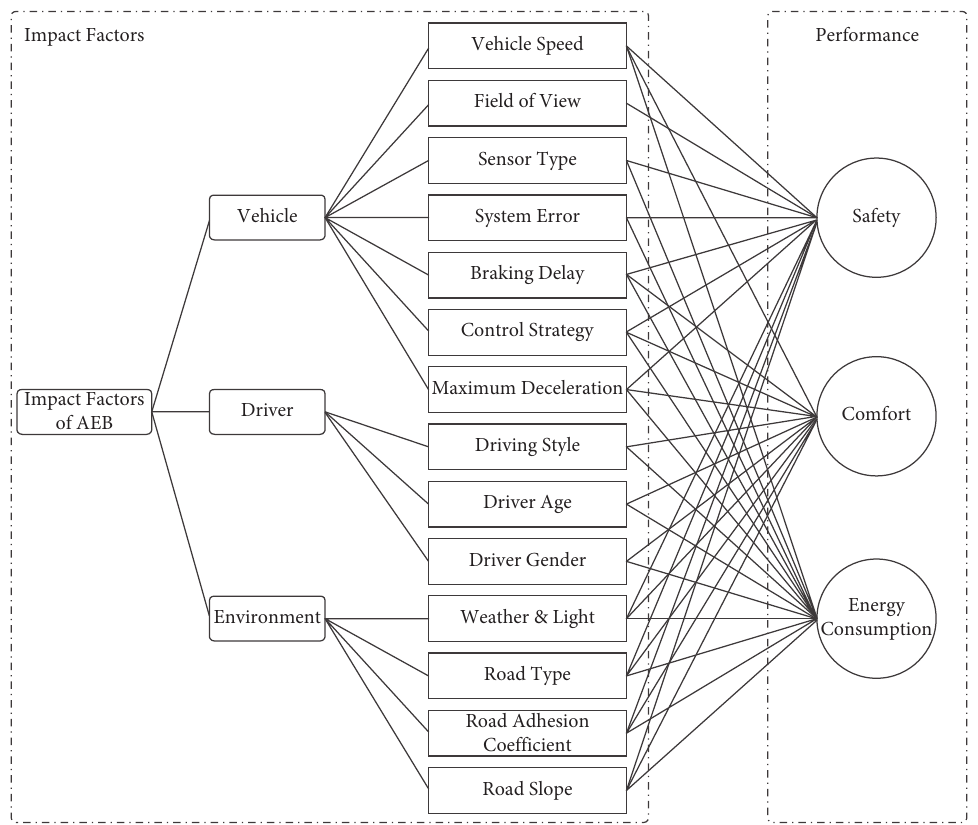
Figure 2: Impact factors of AEB